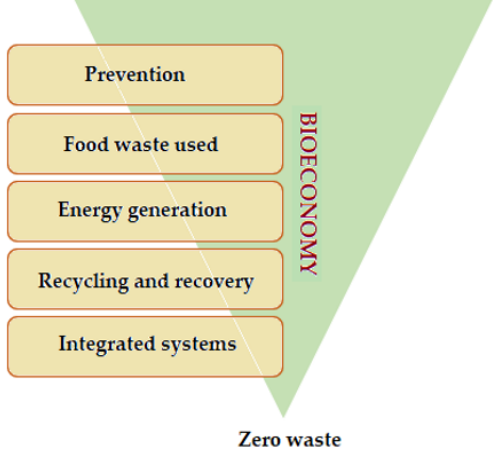
Figure 1. Bioeconomy system in relation to food waste (modified after [32]).